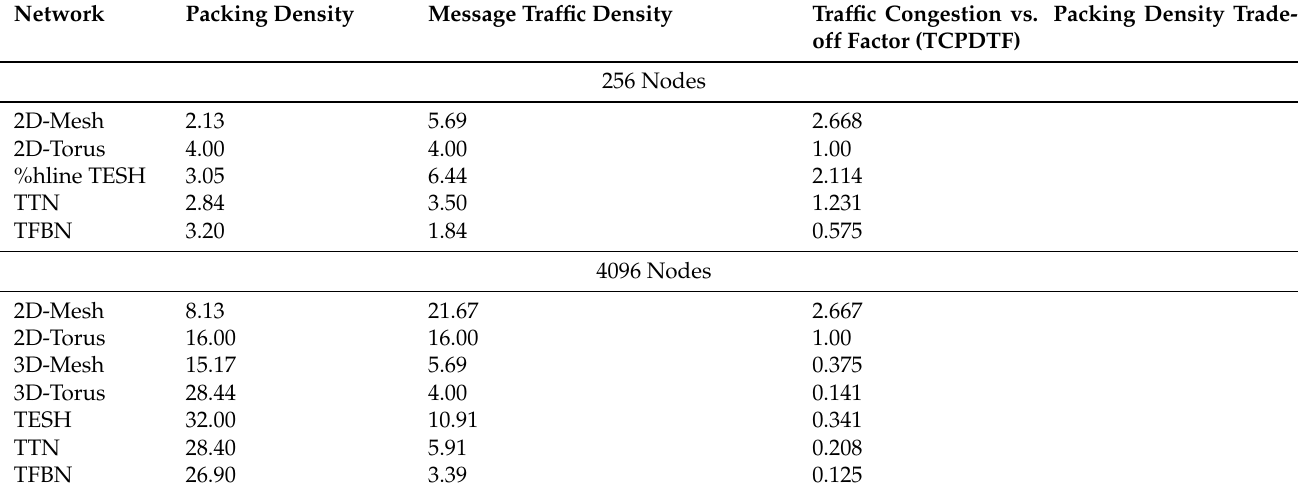
Table 2. Performance comparison of the packing density, message traffic density, and the TCPDTF of various networks.